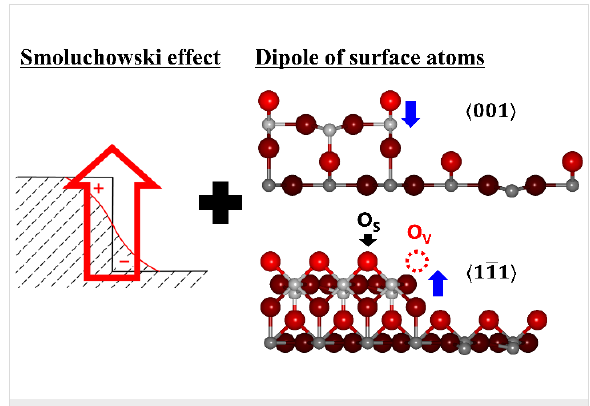
Figure 4: Schematic model for interpreting the local surface potential at the steps that combines the upward dipole moment, in analogy to the Smoluchowski effect, and the local atomic dipole moment. Blue arrows indicate the direction of the local atomic dipole